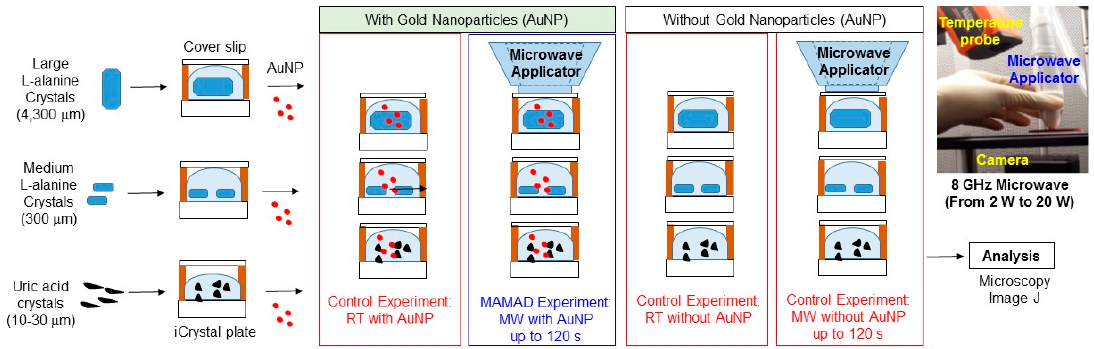
Figure 10. Schematic depiction of experimental procedures used for the decrystallization of uric acid and L -alanine crystals of various sizes using the MAMAD technique and control experiments.